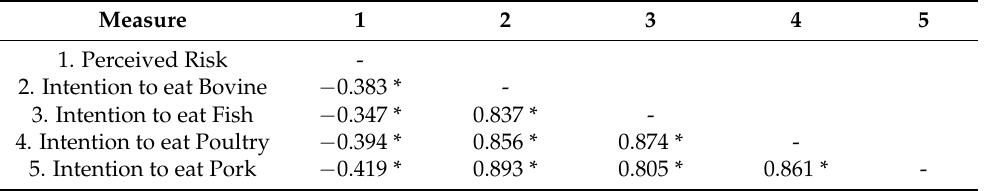
Table 7. Table of correlations of perceived risk and intention to eat different animals fed with insects ( n =